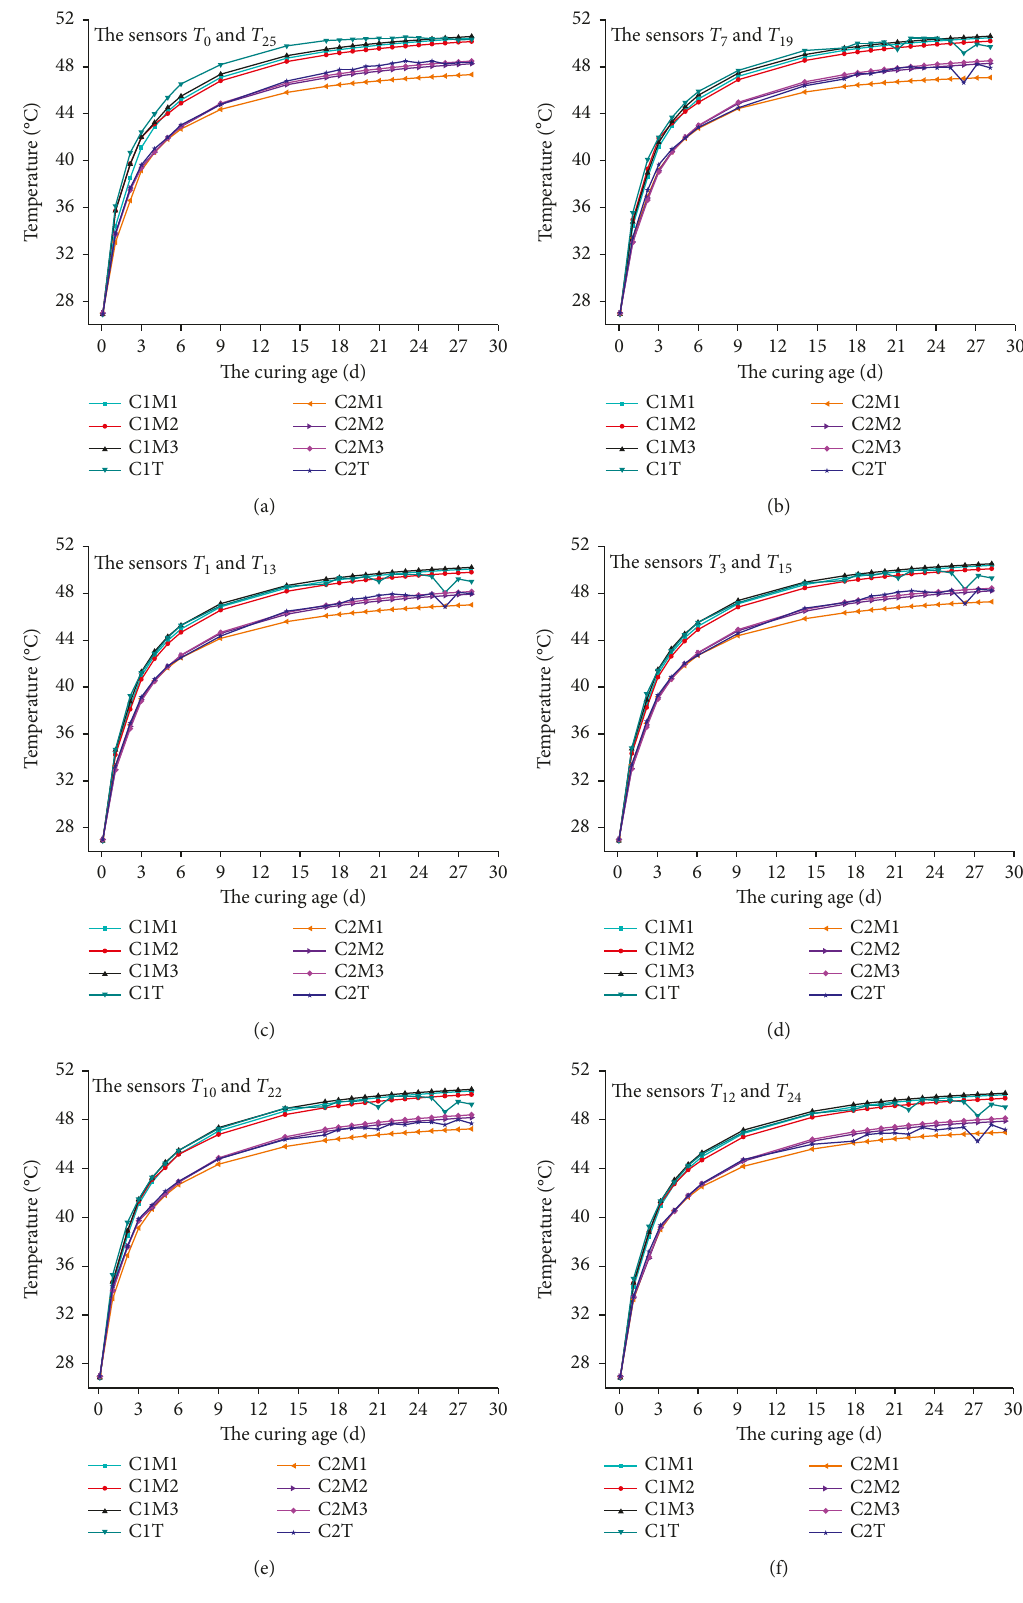
Figure 7: Historic curve of temperature at specified